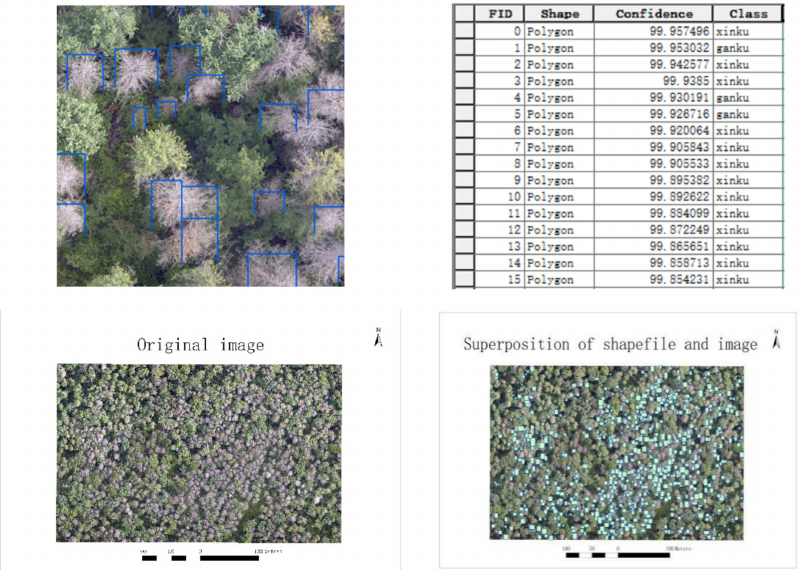
Figure 13. ( a ) YOLO v4 final detection effect. ( b ) Shapefile attribute representation intent. ( c ) Original image. ( d ) Shapefile overlaid with image